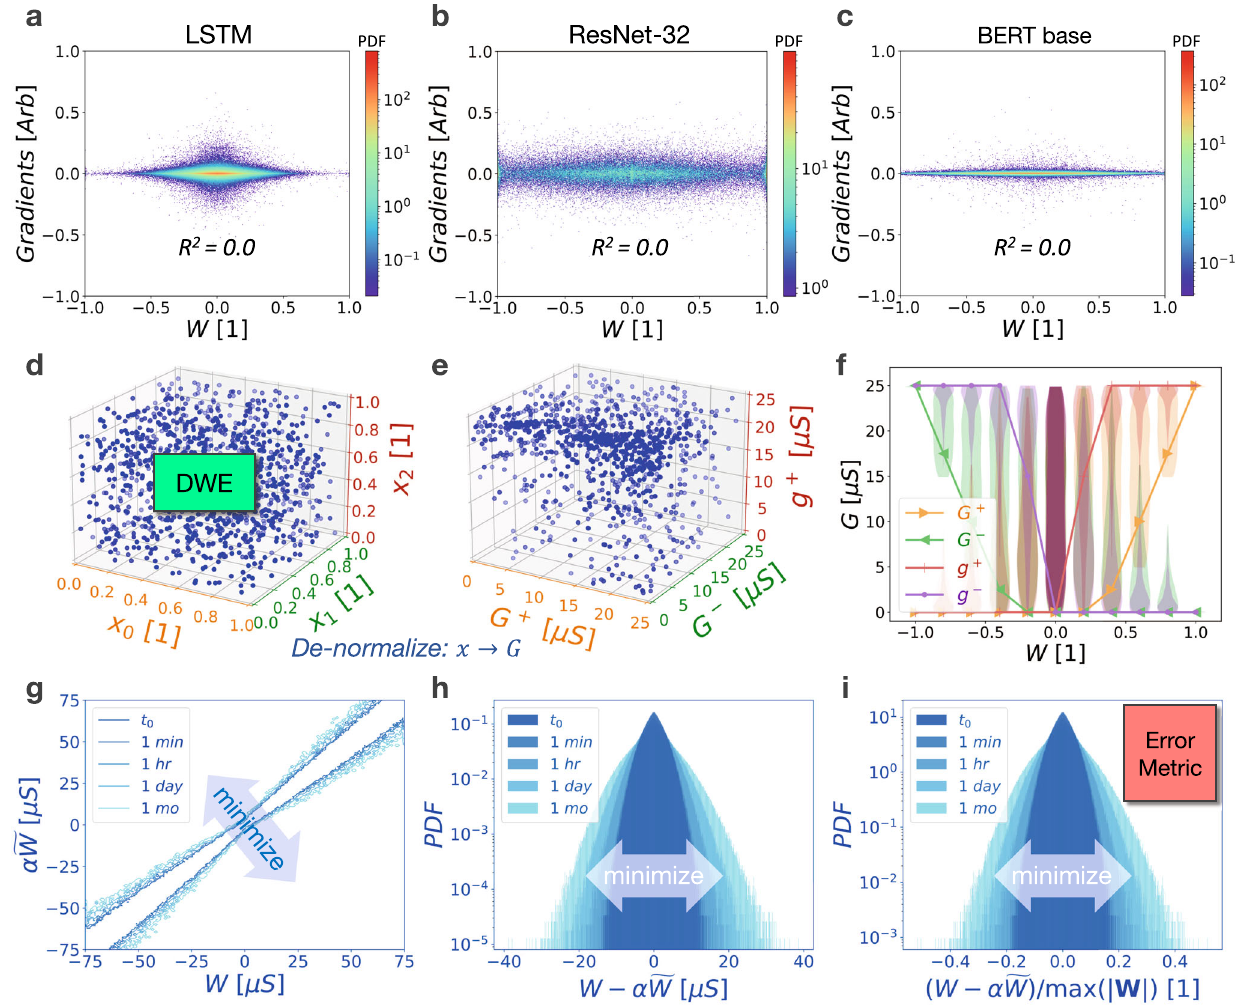
Fig. 3 Algorithmic details of weight programming optimisation. DNN gradients are uncorrelated with weight value as shown for ( a ) LSTM, ( b ) ResNet- 32, and ( c ) BERT-base. This leads to a weight error importance κ j , as de fi ned in our error metric, which depends solely on weight density. The weight programming parameter space is then explored using ( d ) Differential Weight Evolution (DWE) on parameter vectors x within a (cid:4) 4 D þ 2 dimensional hypercube, where D represents the number of positive discretised weights. e De-normalised hypercube parameters produce valid conductance combinations that capture optimisation constraints due to conductance inter-dependencies. f A two-dimensional projection of the weight programming strategies explored, including the optimal solution (solid lines). Background violin plots show coverage of the weight programming space explored and reveal underlying programming constraints. g Outlines of correlation distributions for drift compensated hardware weights α e W versus ideal weights W showing an outward diffusion over time. h The corresponding probability density function of weight errors across all weight magnitudes, showing a similar outward diffusion with time. i The resulting normalised weight error distribution used to de fi ne the error